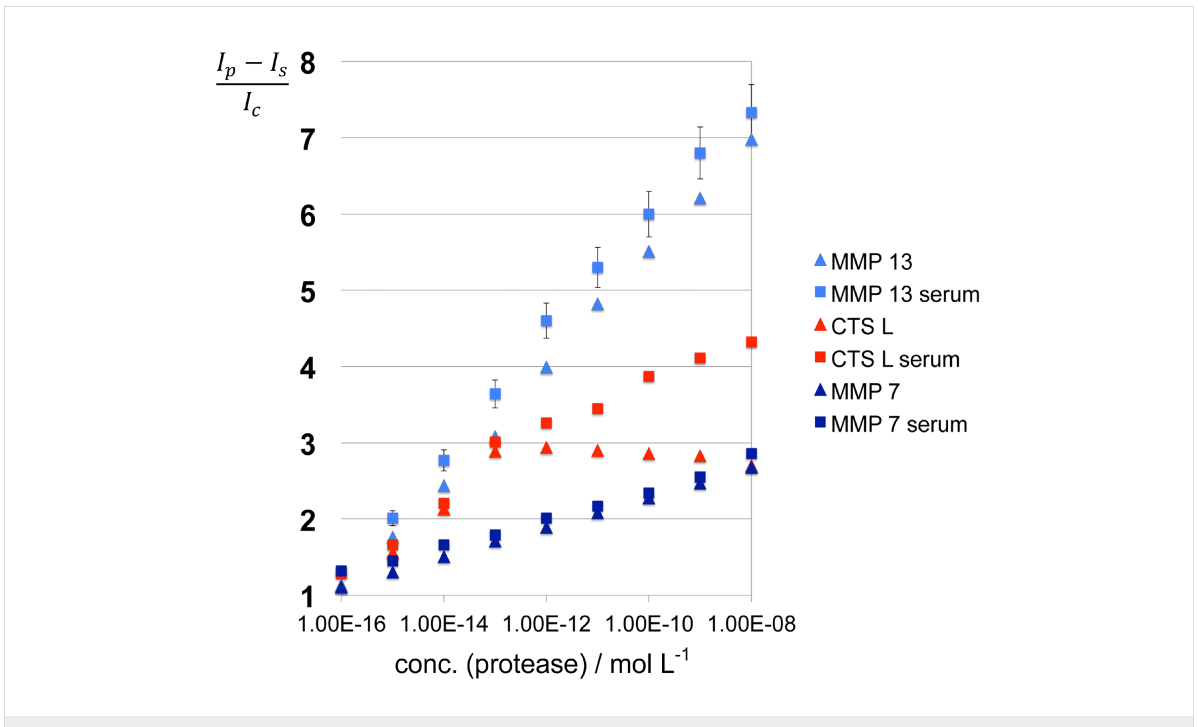
Figure 4: Matrix effects for MMP7, MMP13, and cathepsin L after 60 min of incubation at 25 °C under standard conditions. I p : fluorescence signal after 60 min of incubation; I c : fluorescence signal in the absence of protease after 60 min incubation; I s : fluorescence signal of serum/PBS-dextran alone. Experimental errors are